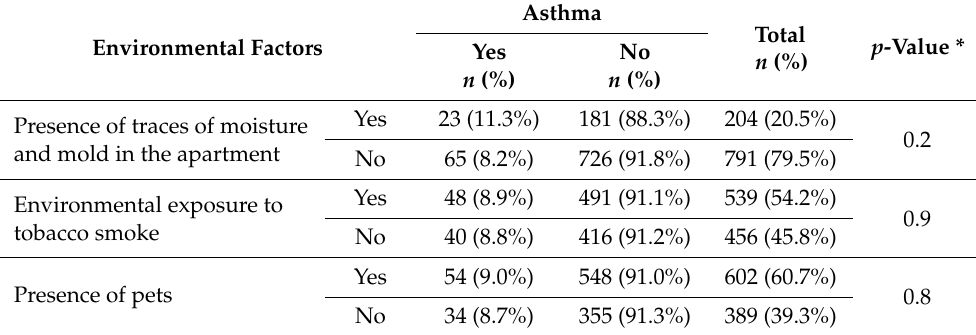
Table 5. Environmental factors and prevalence of asthma.